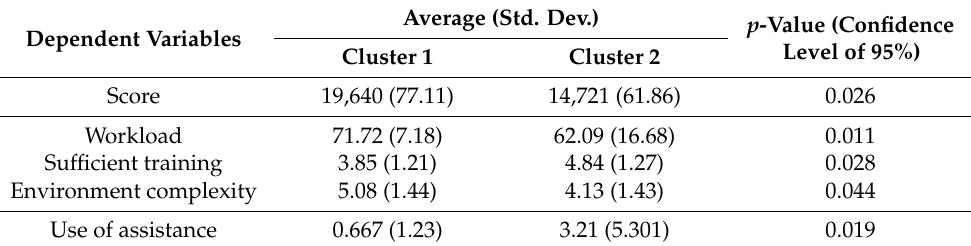
Table 8. Averages of the participants’ performance per group and the result of the significance